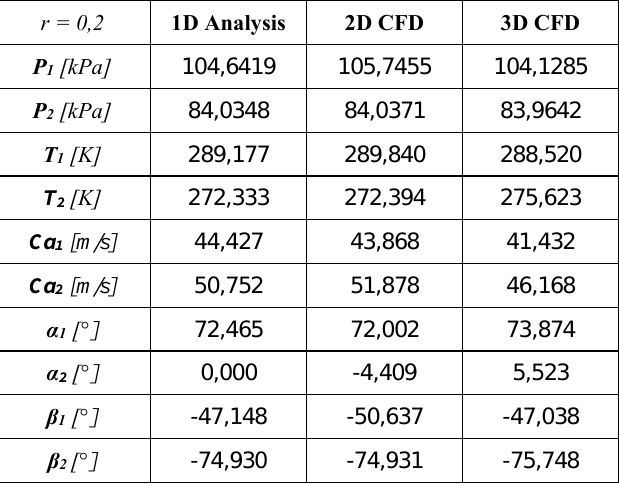
Table 4. Results on the tip end wall (r = 0,2